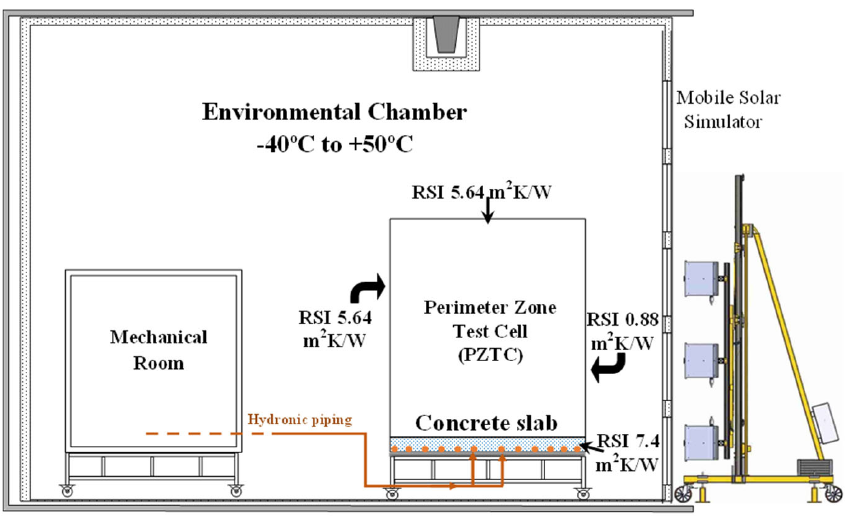
Figure 3. Schematic of SSEC with PZTC and radiant floor. A low-order (second-order) grey-box model was developed by the authors for the PZTC. Figure 4 shows thermal network model of the PZTC. To study the effect of variable window to wall ratio (WWR) on energy flexibility, initially 50% WWR was considered for the front façade of the